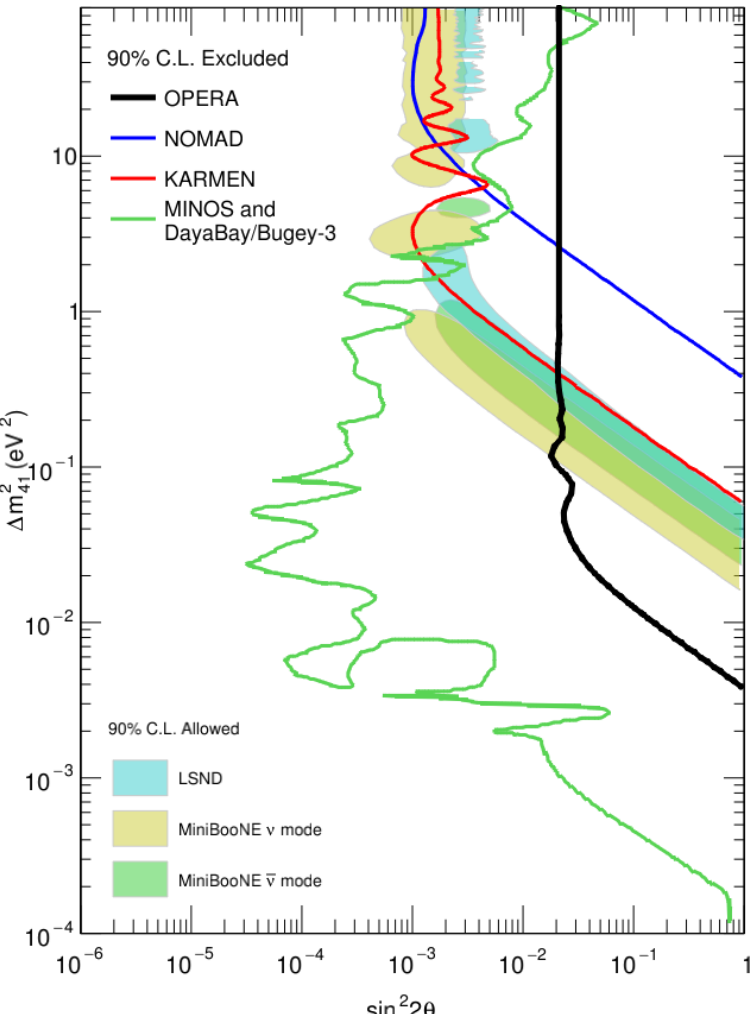
Figure 4 . The 90% C.L. exclusion plot in the (cid:1) m 2 and sin 2 2 (cid:18) (cid:22)e plane is shown (black line) 41 together with the 90% C.L. allowed region obtained by LSND (cyan) and MiniBooNE (yellow and green for (cid:23) and (cid:22) (cid:23) mode, respectively). The blue, red and green lines represent the 90% C.L. exclusion regions obtained by NOMAD [31], KARMEN [32] and the MINOS and DayaBay/Bugey-3 joint analysis [33],